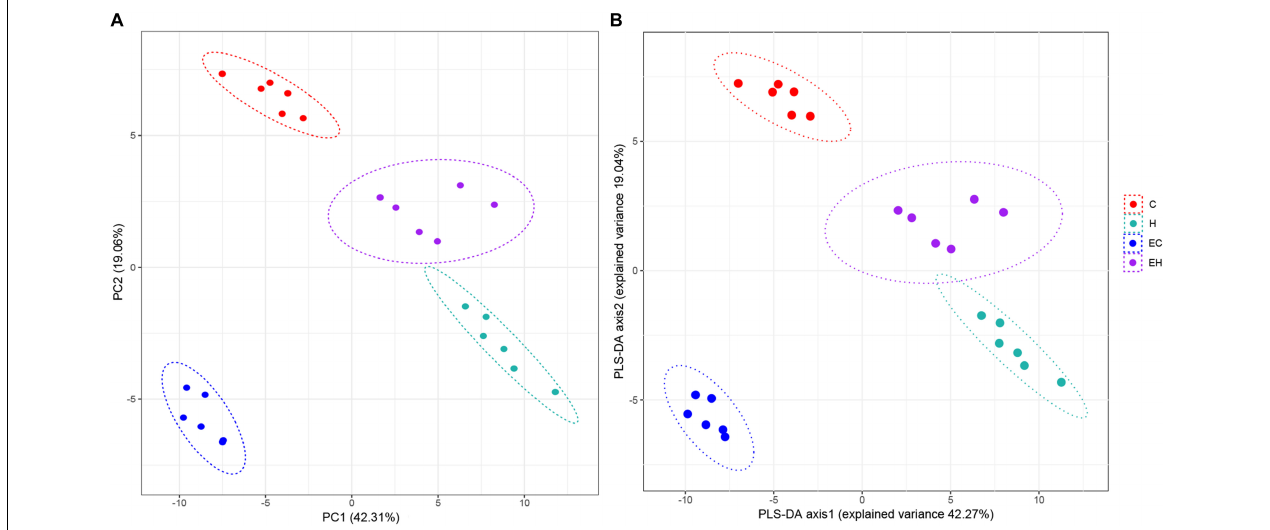
FIGURE 2 | Plot of PCA (A) and PLS-DA (B) scores.